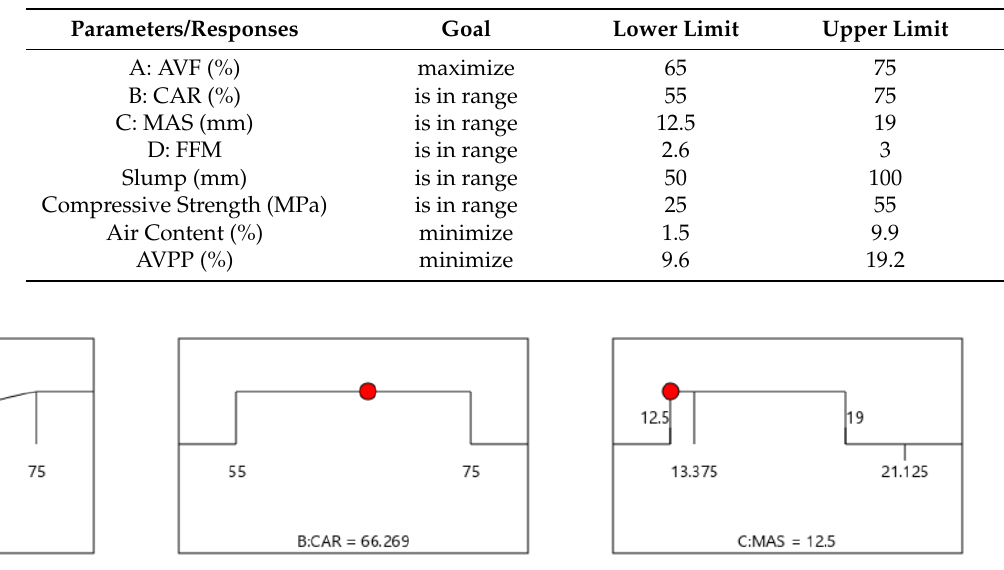
Table 6. Criteria sets for multi-objective optimization.